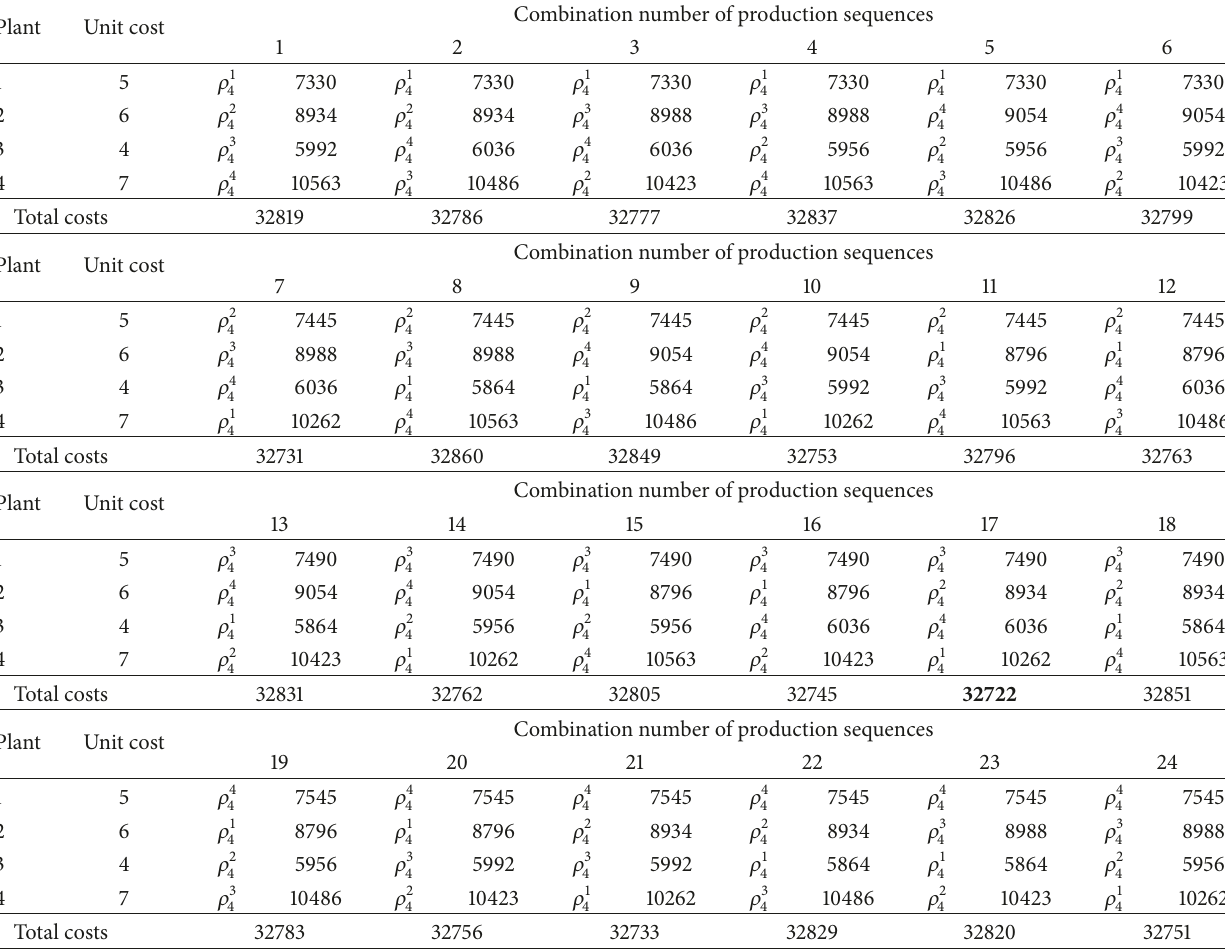
Table 6: Manufacturing costs in the four-plant system (all data).